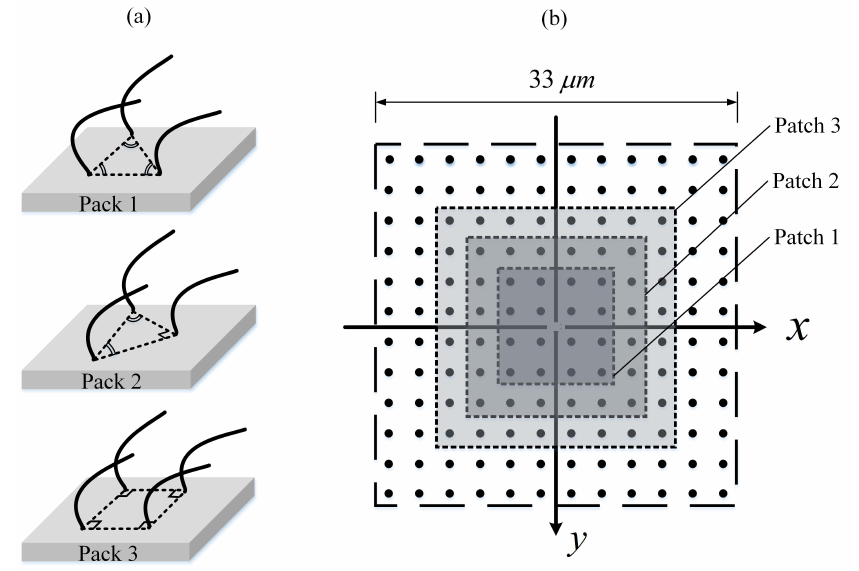
Figure 9. ( a ) Schematic of ciliary pack. (Pack 1): equilateral triangular; (Pack 2): isosceles triangle; (Pack 3): square. ( b ) Schematic of an array of 144 cilia with three patches representing the regions of missing